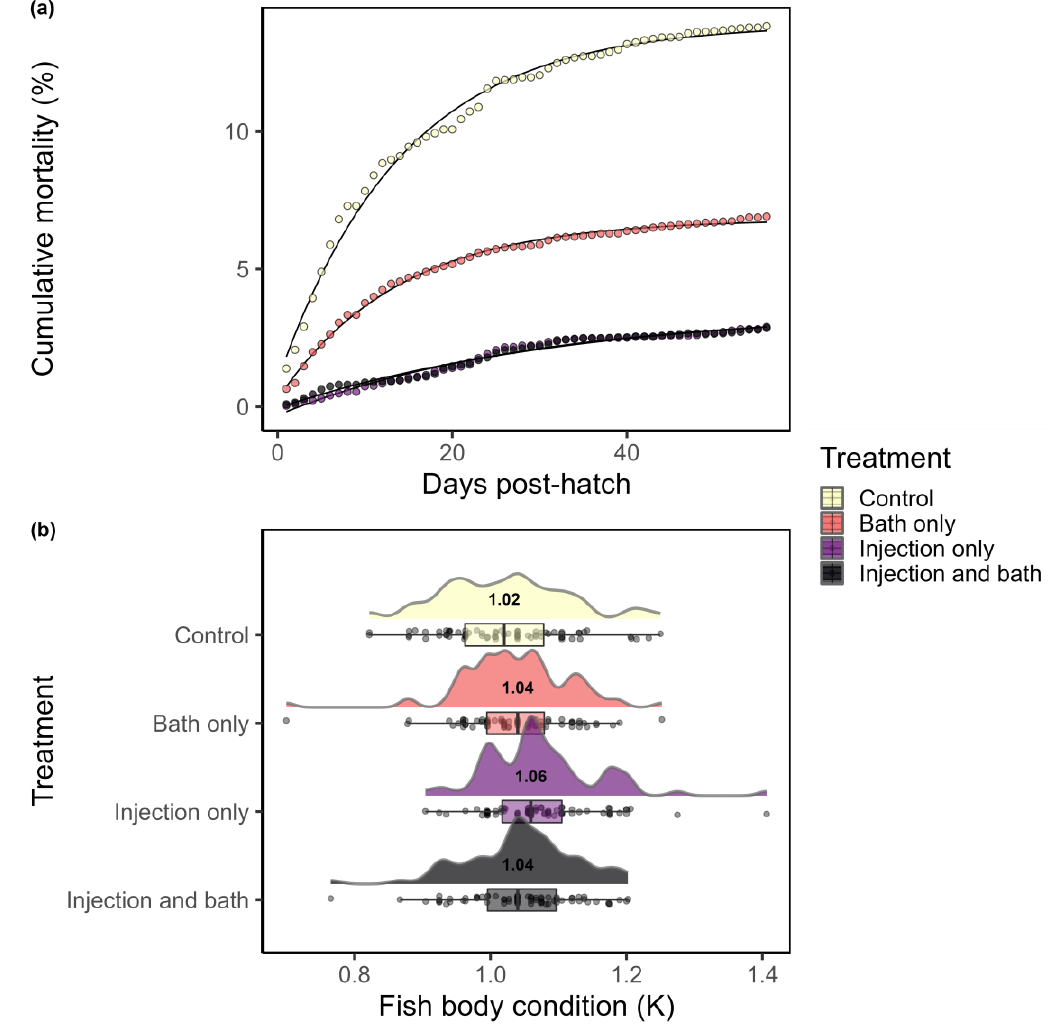
Figure 2. ( a ) Cumulative mortality was assessed daily (points) for 56 days post-hatch in the four treatments with model included as a line; endpoints are control 13.8%, bath only 6.9%, and injection only and injection and bath 2.9%; ( b ) fish body condition, K, of fry 8 weeks post-hatch ( n = 75 each treatment). All data are included overlaid as points on the horizontal boxplot to show the distribution of the data (25%, 50%, and 75% quantiles are included in the box). Overlaid on top of each boxplot is a probability density function to show the density of points at each condition factor with the median value expressed under each curve.